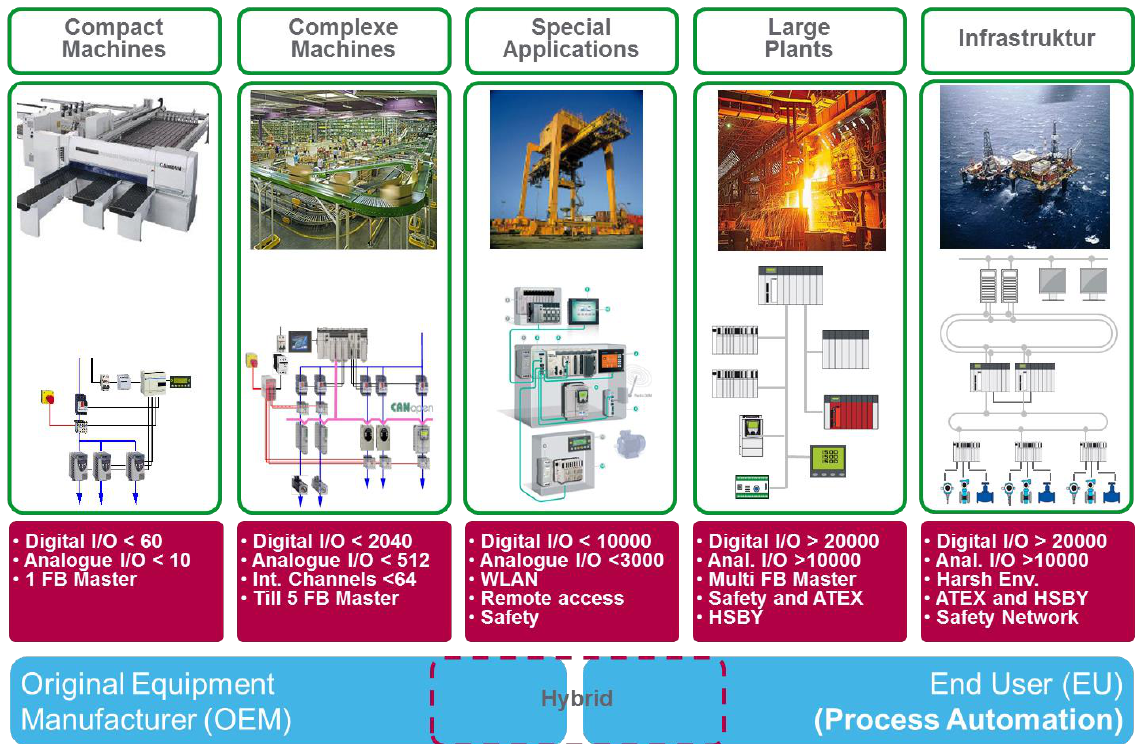
Figure 1. Available automation concepts for machine and